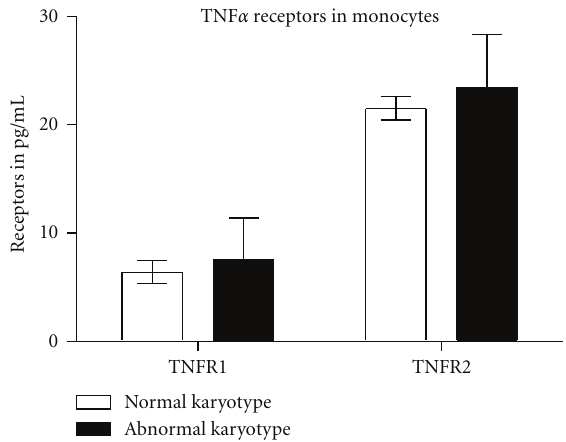
Figure 3: Levels of TNF-R1 and TNF-R2 in monocytes ( n = 12 with normal karyotype and n = 14 with abnormal karyotype). There was no significant di ff erence in any of the intracellular levels of